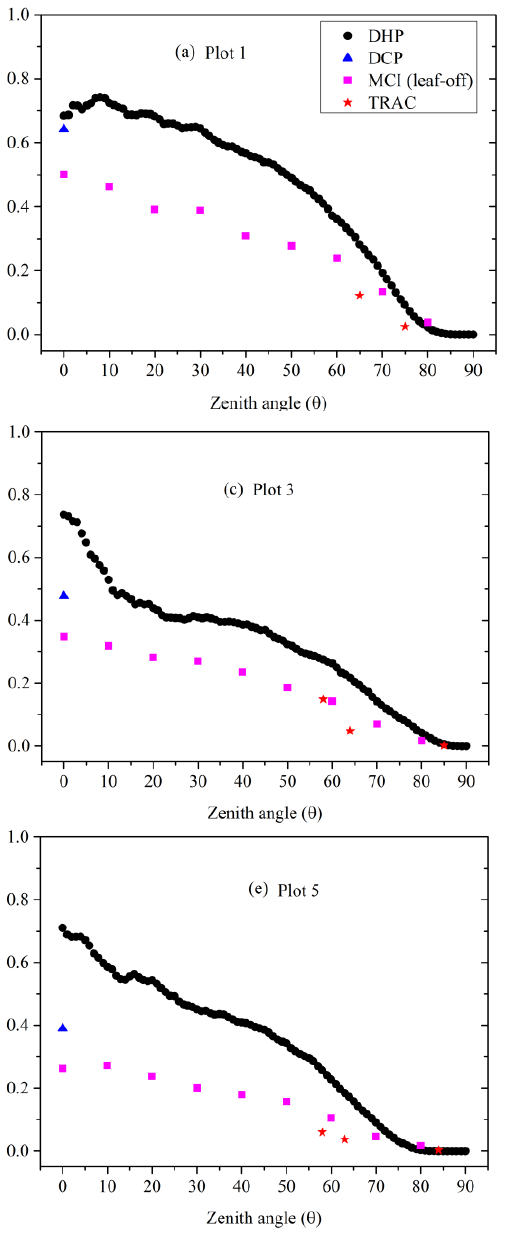
Figure 2. Woody components gap fraction ( 𝑝 𝑤 (𝜃) ) measurements obtained from DHP, TRAC, MCI, and DCP in the five leaf-off plots: ( a ) plot 1, ( b ) plot 2, ( c ) plot 3, ( d ) plot 4, and ( e ) plot 5.